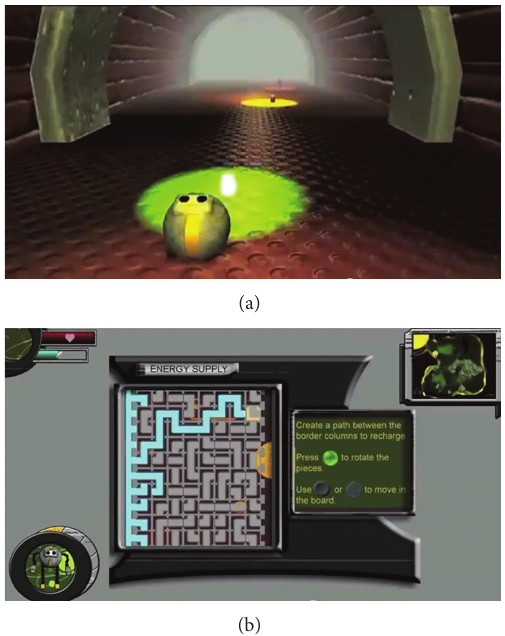
Figure 10: Other learning mechanisms: (a) mini-game associated to garbage collection; (b) mini-game associated to the recharge of